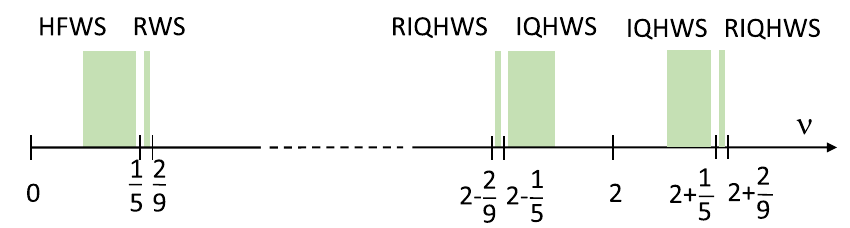
Fig. 4 Schematic diagram of the stability regions of the various Wigner solids in GaAs/AlGaAs system. The Wigner solid we report on is the reentrant integer quantum Hall Wigner solid (RIQHWS), seen between the fi lling factors ν = 2 − 1/5 and 2 − 2/9. The high- fi eld Wigner solid (HFWS) and integer quantum Hall Wigner solid (IQHWS) are related by particle – hole symmetry. Similarly, the reentrant Wigner solid (RWS) and the reentrant integer quantum Hall Wigner solid (RIQHWS) are also related by particle –